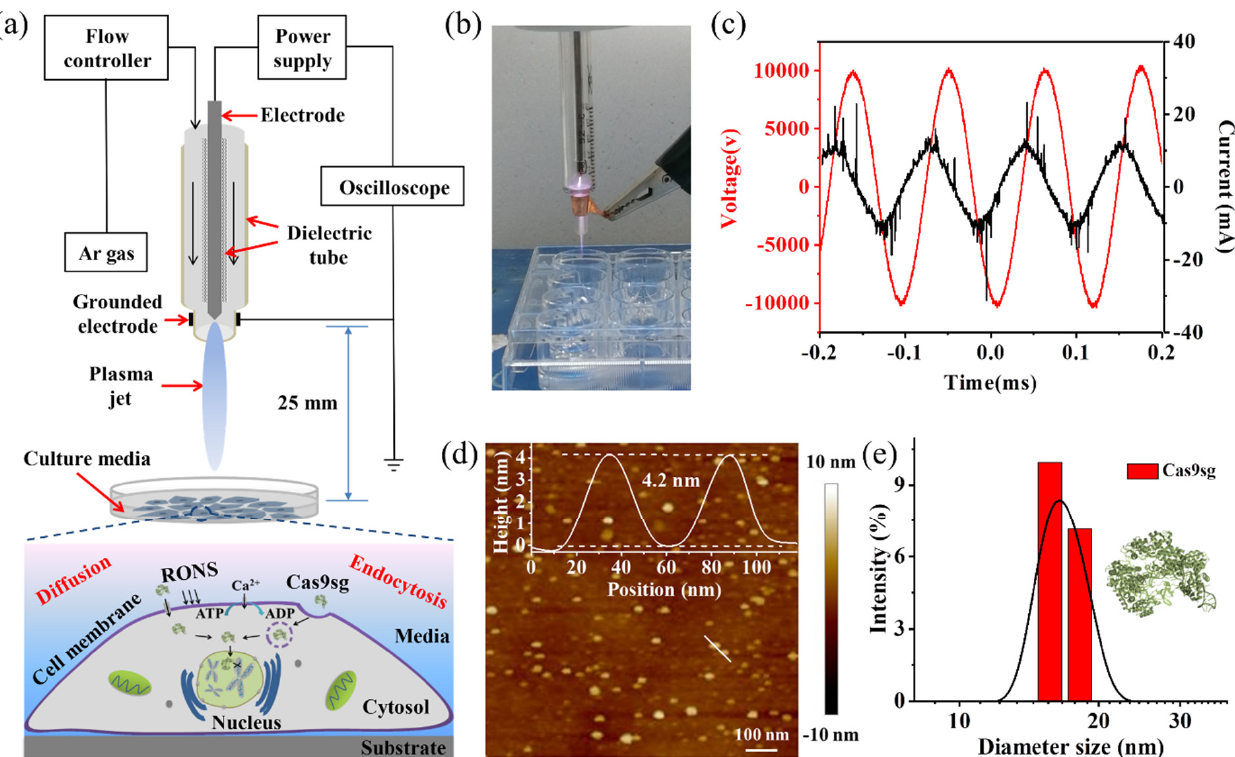
Figure 1. CAP-mediated cellular transport and characterization of Cas9sg: ( a ) Schematic illustration of CAP-mediated Cas9sg cellular transport for genome editing; ( b ) Image of CAP; ( c ) Voltage and current characteristic of CAP; ( d ) Morphology, and ( e ) Size distribution of Cas9sg determined by AFM and DLS measurements.